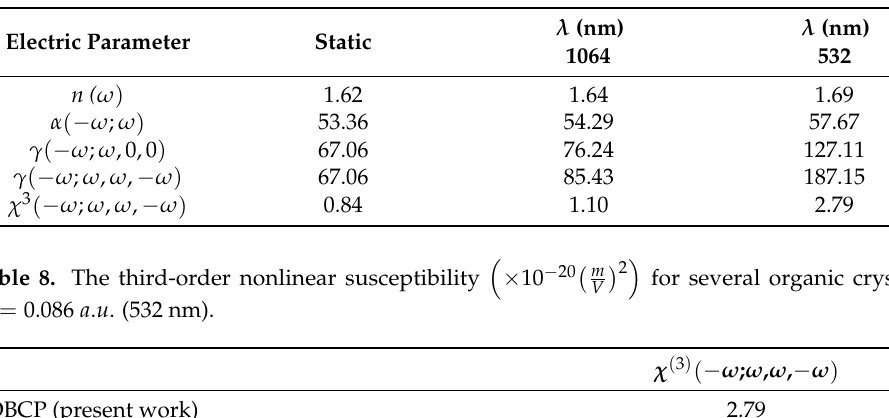
Table 7. Static and dynamic results for the refraction index ( n ), linear polarizability average second hyperpolarizabilities ( γ in 10 − 36 esu ) and third-order nonlinear susceptibility ( χ 3 in 10 − 20 m 2 / V 2 ) of the QBCP-embedded molecule.